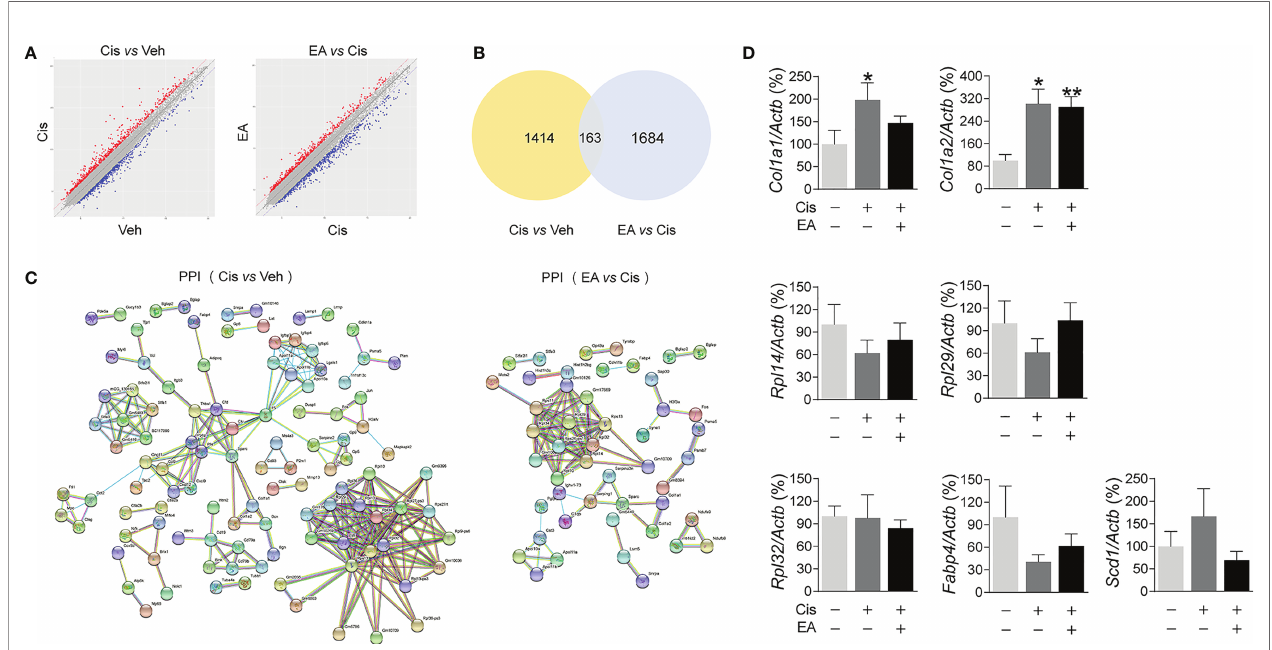
FIGURE 3 | Analyses of expression and enrichment of electroacupuncture in the bone marrow of mice with cisplatin. (A) Scatter plots of differentially expressed genes (DEG)s in Cis vs Veh and EA vs Cis group Each probe is represented by a point with red and blue points showing up- and down-regulated genes de fi ned above Log2 FC > 2. (B) Venn diagram and (C) PPI network analyses of DEGs results. (D) RT-qPCR analyses of factors related to extracellular matrix ( Col1a1 , Col1a2 ), ribosome ( Rpl14 , Rpl29 , Rpl32) , and PPAR signaling ( Fabp4 , Scd1) ( Col1a1 , Col1a2 : n =7 per group. Rpl14 , Rpl29 , Scd1 : n =6 per group. Rpl32 , Fabp4 : Veh, n =6; Cis, n =5; EA, n =6). Data are mean ± SEM, * P < 0.05, ** P < 0.01 vs Veh.